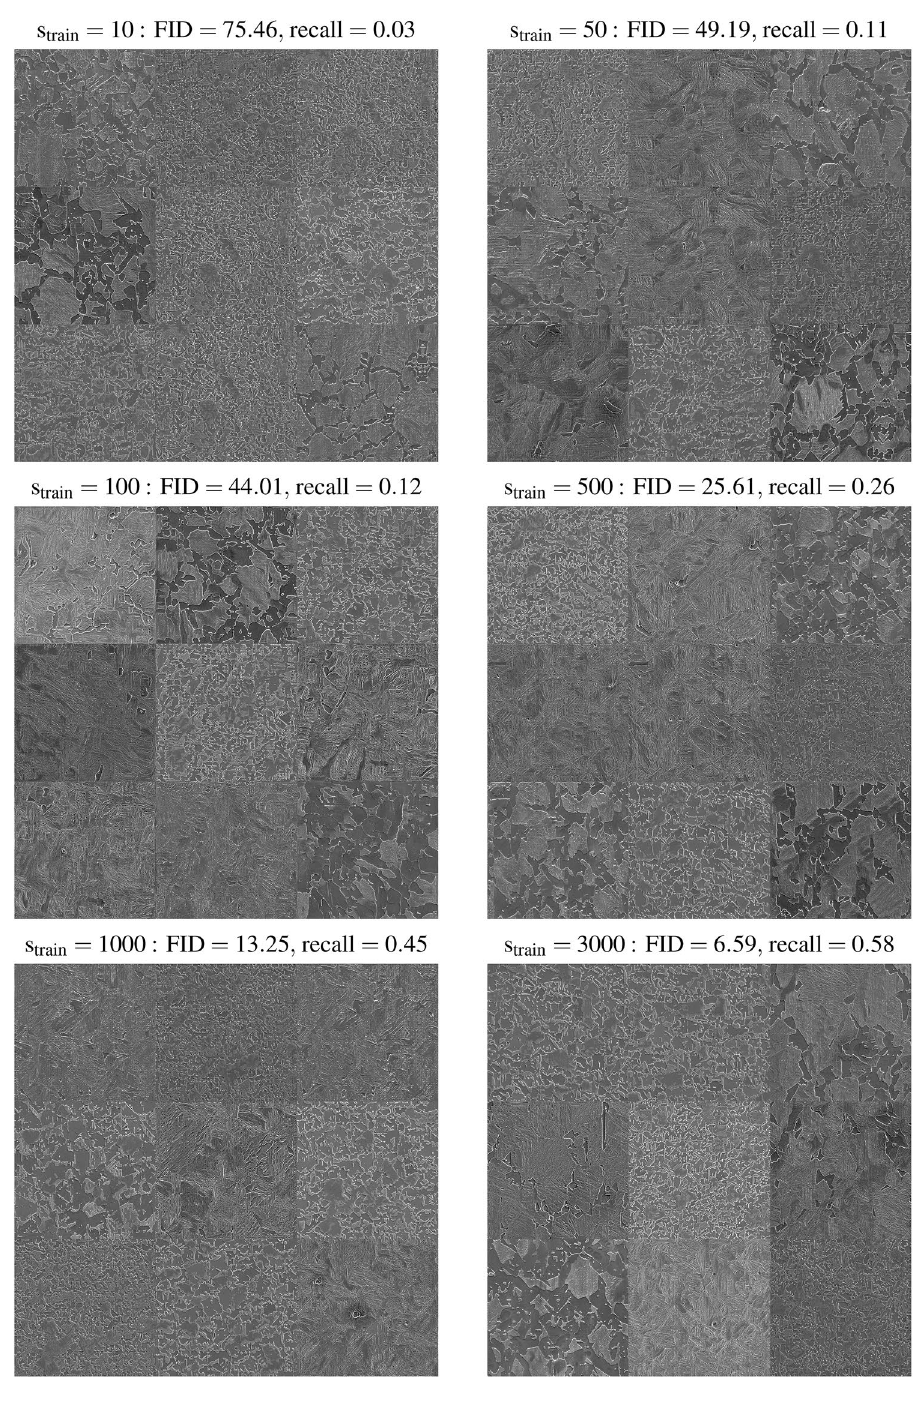
Figure 4. Samples of non-curated SEM images generated with the StyleGAN2 with ADA 8 trained from scratch on a size of the training set, s train = 10, 50, 100, 500, 1000, 3000 (all) SEM images from our dataset. For each s train , the best Fréchet inception distance 36 (FID, lower is better) and recall 37 (higher is better) median values are reported. Training runs are conducted with pixel blitting and geometrical transformations as ADA and a target heuristic r t = 0.5